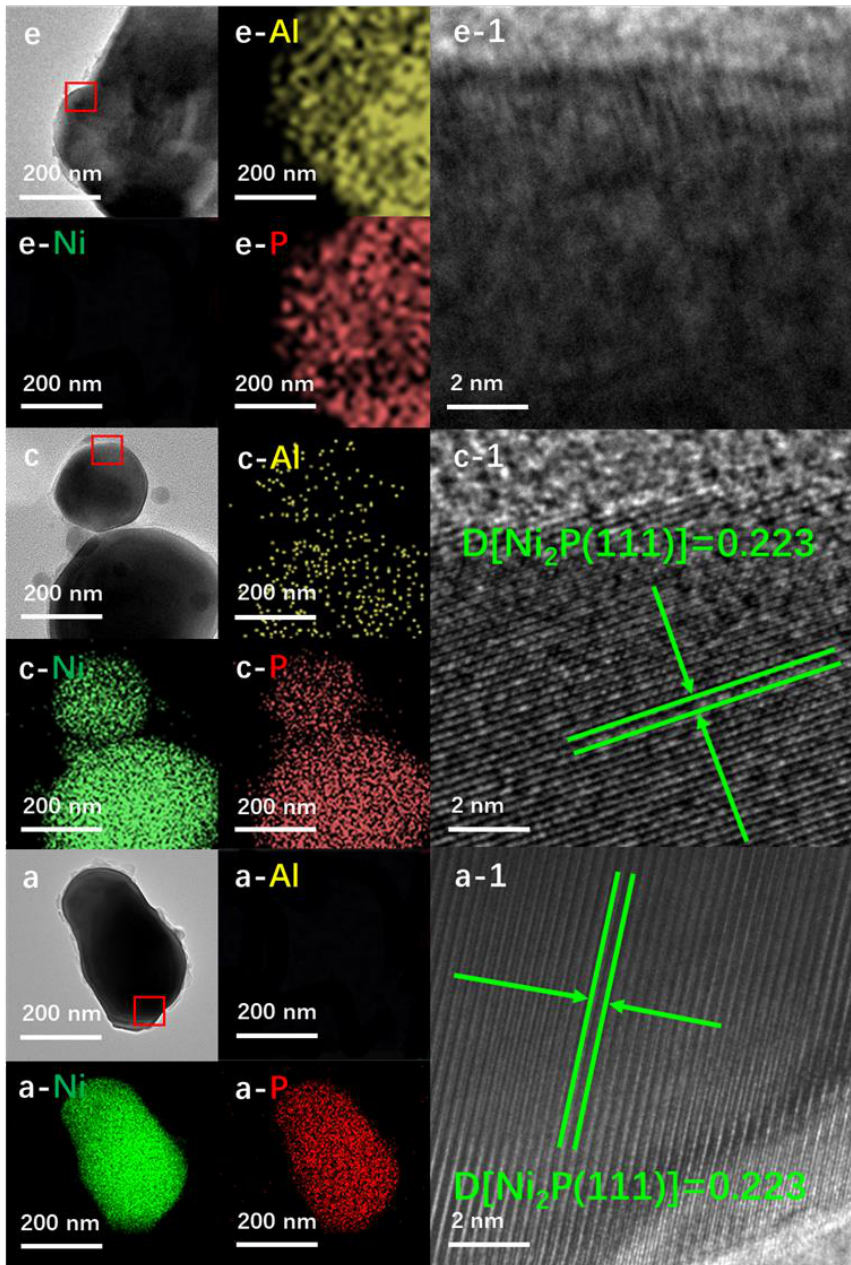
Figure 2. EDS mapping and HRTEM (enlarged from the marked area of the first column) images for the representative samples. a. Ni 2 P; c. (AlPO 4 ) 0.1 /Ni 2 P; e. AlPO 4. Table 1. Surface physical chemistry parameters of typical catalysts and their performances.